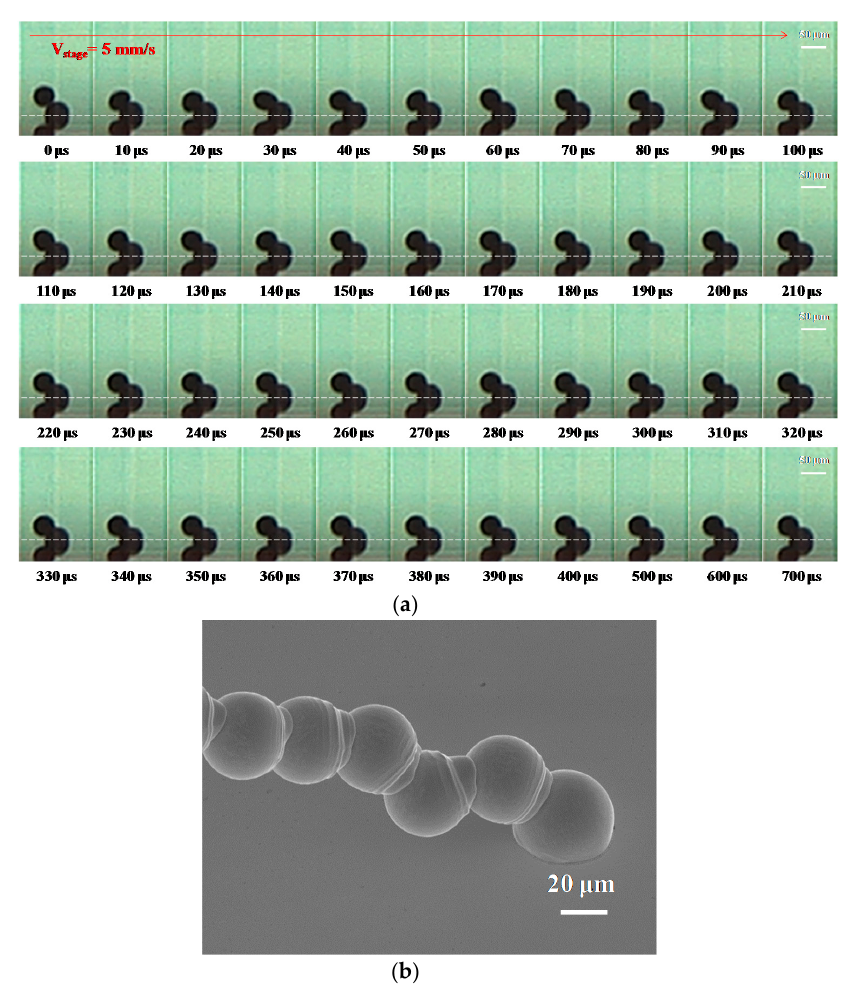
Figure 3. The deposition of molten metal droplets under a dot spacing of 25 μ m with the following initial characteristics: diameter D 0 = 50 μ m, velocity = 1.1 m ∙ s − 1 , stage velocity = 5 mm ∙ s − 1 (frequency = 200 Hz) and sample temperature 30 °C (Stefan number Ste = 0.722). ( a ) Evolution of a droplet impacting onto a solidified droplet recorded using a high-speed digital camera with condition A in Table 2. The dashed lines separate the outline of the droplet from that of its reflection on the substrate. The scale bars are 50 μ m; ( b ) tilted 40° SEM photograph of the droplets deposited on a gold-plated glass substrate. The scale bar is 20 μ m.